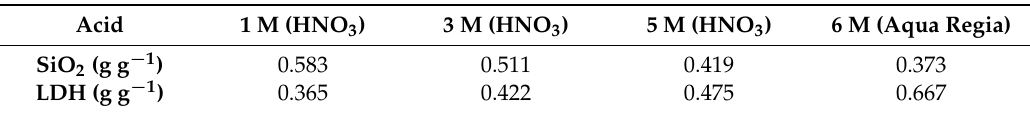
Table 1. The quantities of the obtained SiO 2 and Mg-Al-CO 3 LDH when the vermiculite was treated with different concentrations of leaching